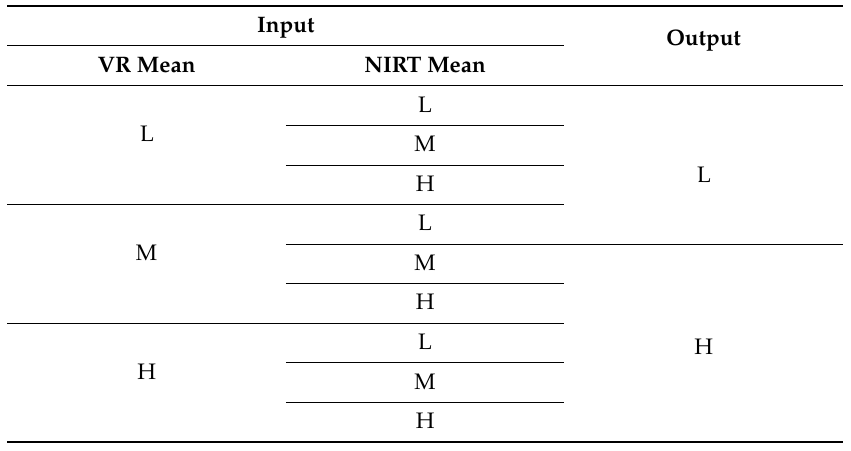
( b ) Figure 6. Example of calculating output value from input feature value input membership function: ( a ) Output value for VR mean; ( b ) Output value for NIRT mean. Table 2. Example of IVs obtained by Fuzzy rule, Min rule, or Max rule. Index